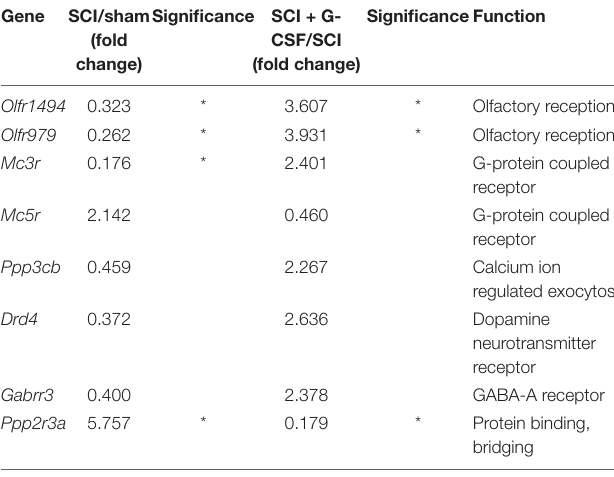
TABLE 1 | Results of mRNA microarray analysis of mouse whole brain 8 h following